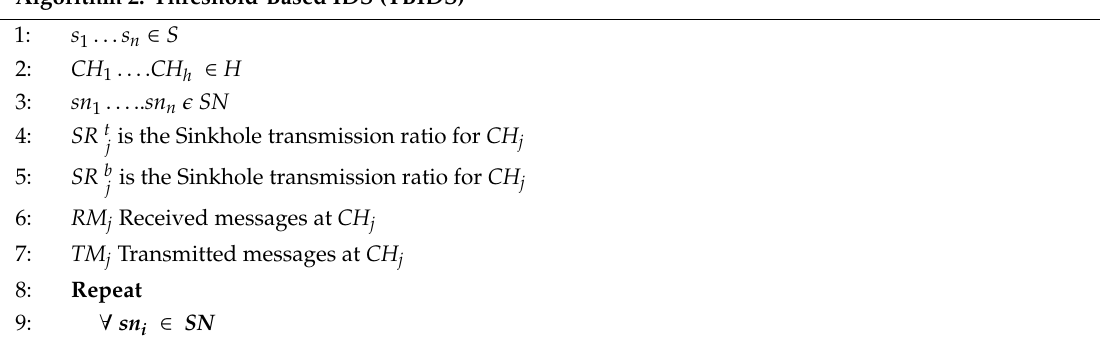
Algorithm 2. Threshold-Based IDS